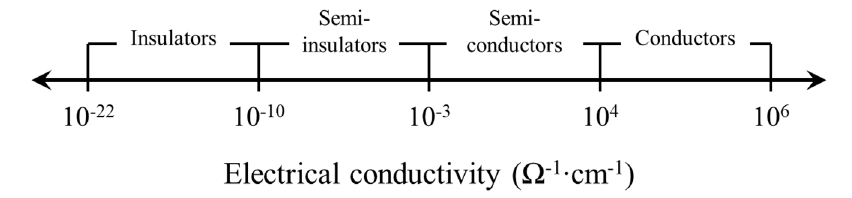
Figure 8. Scale of electrical conductivity [34].